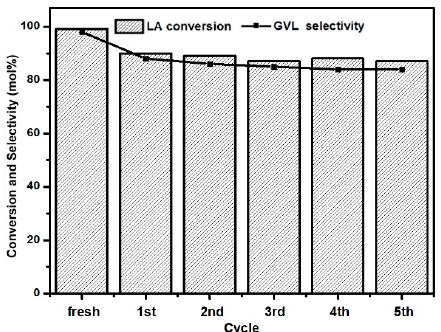
Figure 6. Recycling tests of 5Ni-3Fe / SBA-15